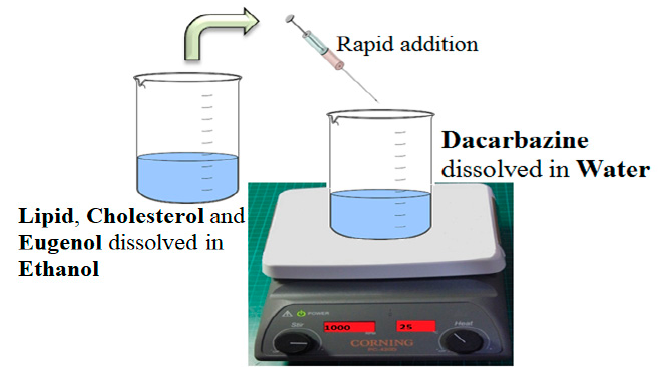
Figure 1. Method of Preparation of dual loaded Liposomes. An ethanolic solution of lipid, cholesterol and the lipophilic drug is rapidly injected into an aqueous solution of a hydrophilic drug, under stirring. Spontaneous formation of liposomes takes place.